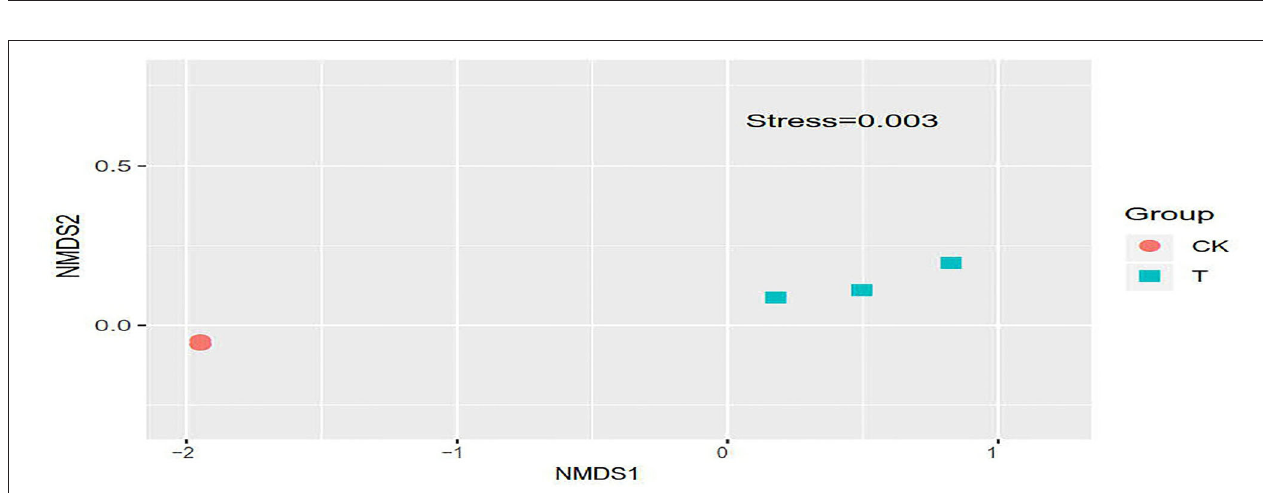
FIGURE 6 | Relative abundance of species at the phylum level. The abundance is represented in terms of the percentage of the total effective bacterial sequences in the sample. The top 10 abound taxa are shown (CK, SBM; T, FSBM).